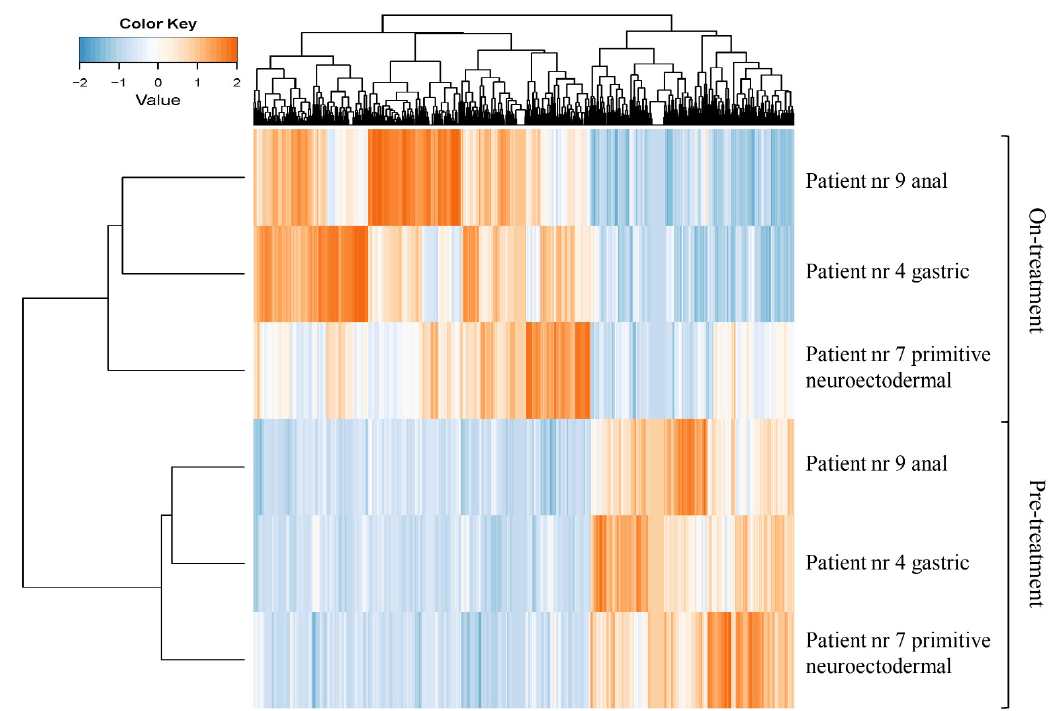
Figure 4. The platelet proteome may be affected by cancer treatment. Heat map and supervised clustering using proteins with differential abundance between platelets of patients with cancer ( n = 3) before the start of antitumor treatment compared to paired platelets samples after initiation of antitumor treatment.